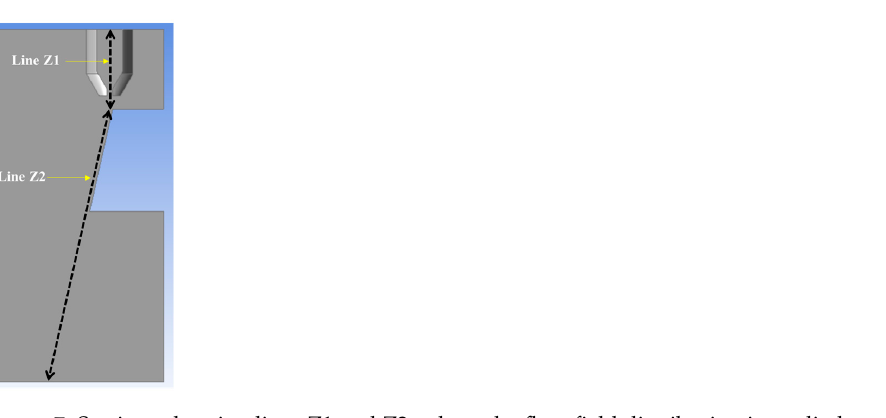
Figure 7. Sections showing lines Z1 and Z2, where the flow field distribution is studied.